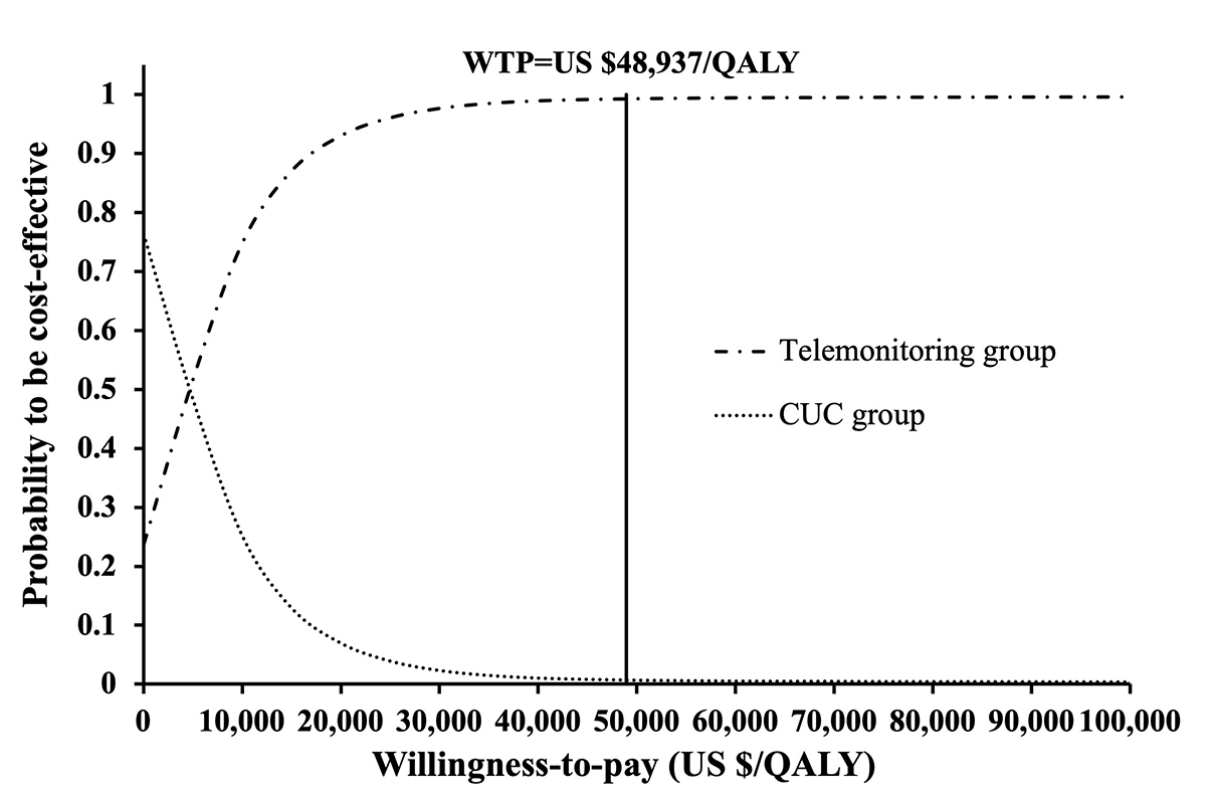
Figure 5. Cost-effectiveness acceptability curve for each strategy to be the preferred strategy against the WTP threshold. CUC: care under